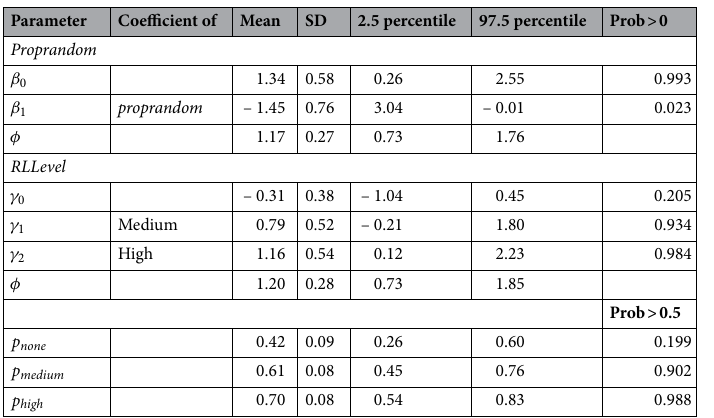
Table 4. Summaries of the posterior distributions of the parameters, showing their mean, standard deviations, and 95% credible intervals. Prob > 0 is the posterior probability of the parameter being positive. The last 3 rows refer to Eq.